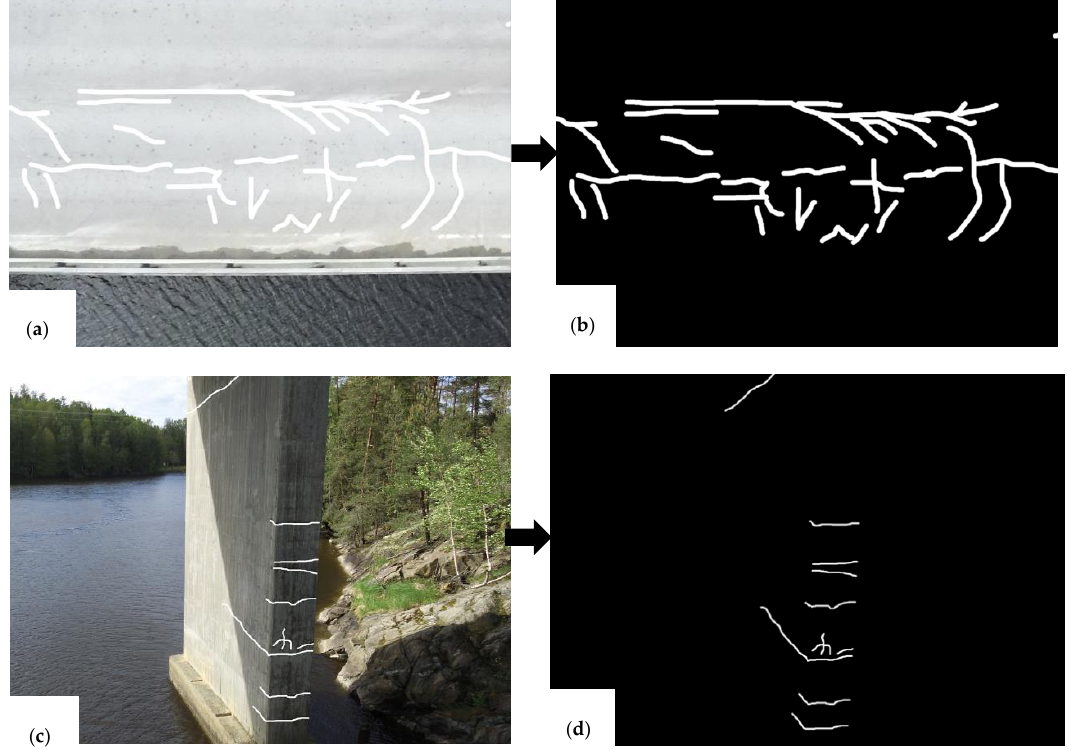
Figure 5. ( a ) drone image of Skodsberg Bridge top view. ( b ) labelled image top view. ( c ) drone image of Skodsberg bridge supporting. ( d ) labelled image bridge supporting.